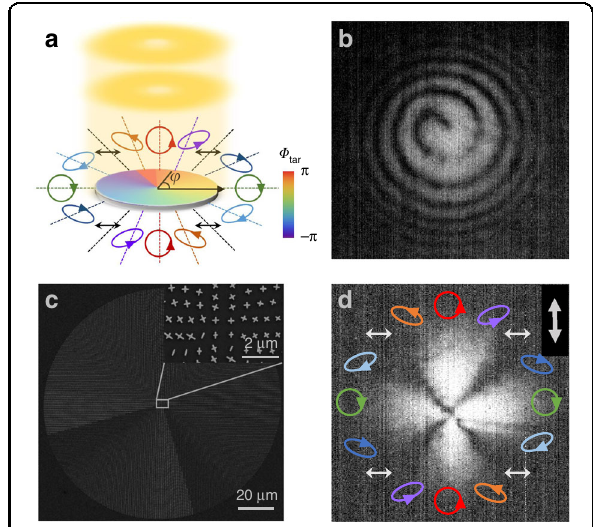
Fig. 6 Schematic, sample picture, and characterization of the vortex beam with varying ellipticity. a Schematic of our proposed meta-device to generate a vortex beam with varying ellipticity. b Interference pattern between the transmitted light and a spherical wave, recorded by our CCD. c SEM image of the fabricated sample. d Optical image recorded by our CCD for the generated VOF after passing through a linear polarizer with a tilt angle of